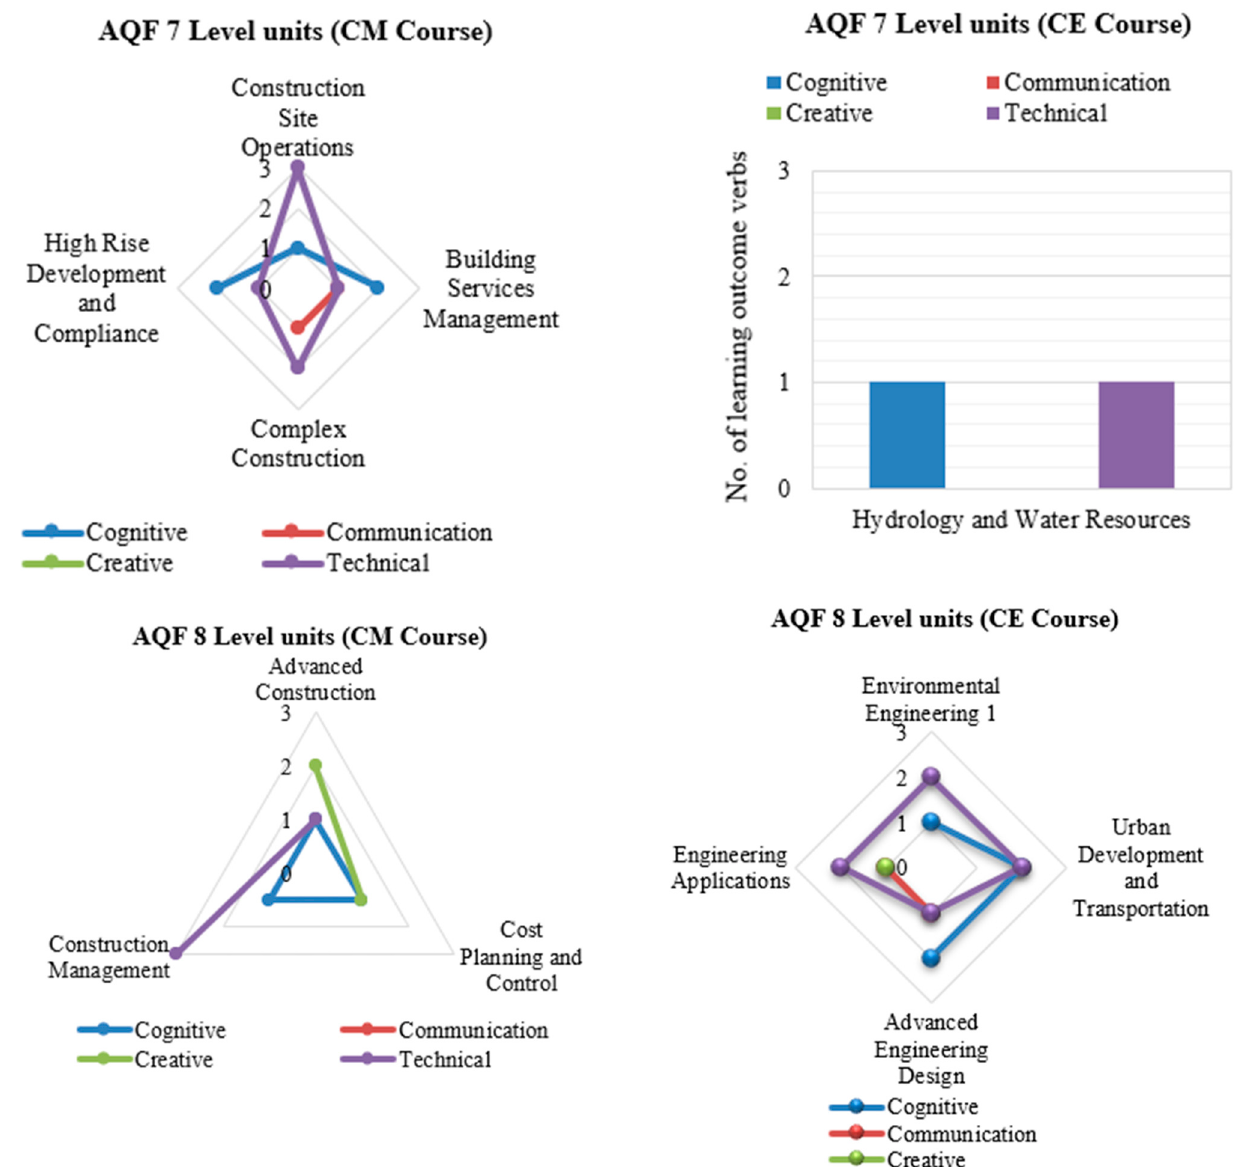
Figure 8. CM units across different AQF levels and AQF verbs’ representation for the four learning areas.